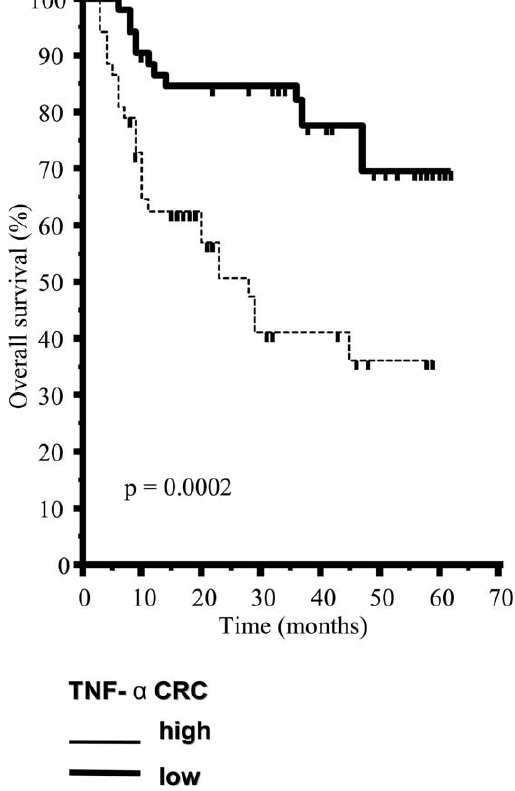
Fig. 7. Overall survival curves calculated according to the Ka- plan–Meier method: Survival of patients with low TNF- α expression profile in CRC is better in comparison to patients with high TNF- α expression ( p = 0 . 0002). The times of the censored data are indi- cated by short vertical